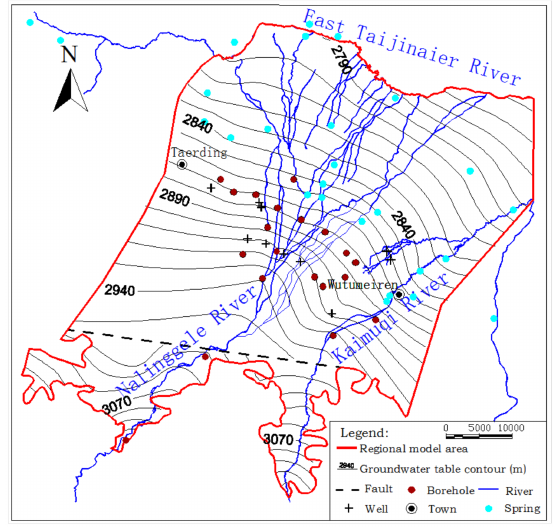
Figure 5. Study area and initial groundwater flow